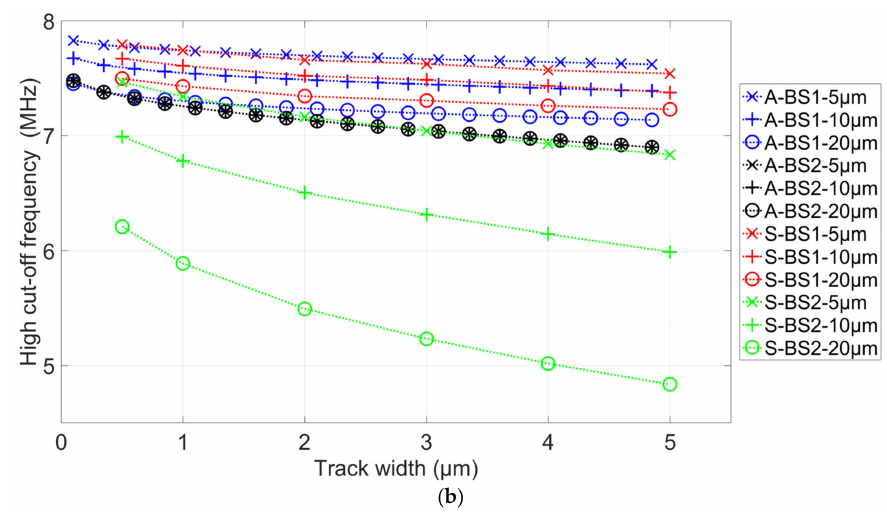
Figure 5. Simulated ( a ) low-cuto ff frequency and ( b ) high-cuto ff frequency as a function of track width for three di ff erent connection length (5 µ m, 10 µ m, and 20 µ m), with and without an insulated layer. “A” corresponds to analytical calculation, and “S” to FEM simulation results.